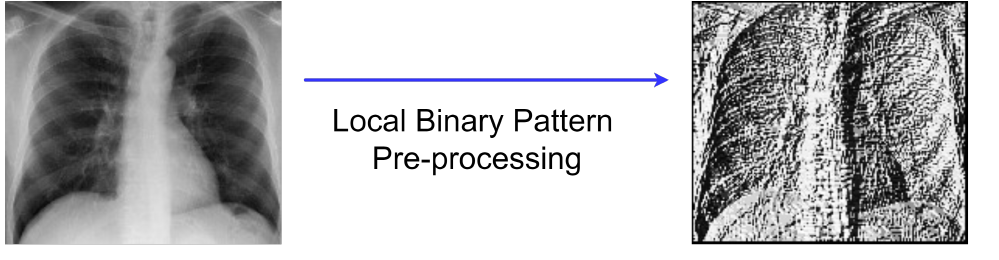
Figure 2. LBP pre-processing.